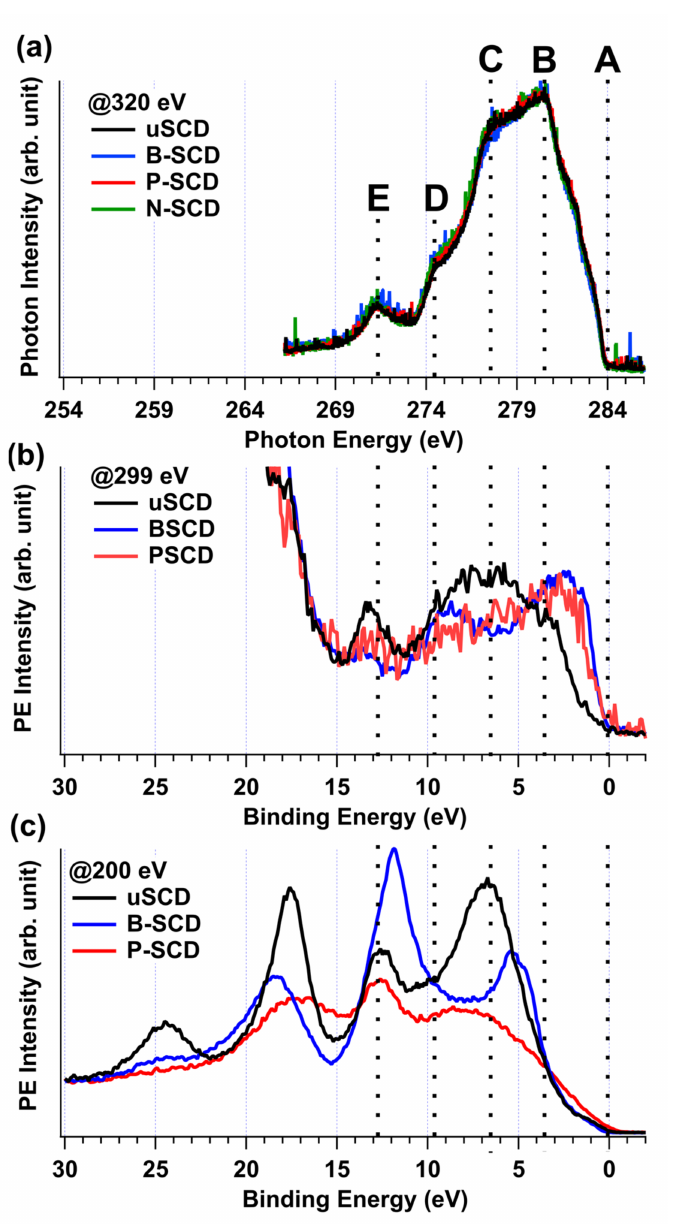
Figure 3. ( a ) XES at the C K-edge of uSCD, B-SCD, P-SCD and N-SCD recorded at 320 eV excitation energy. X-ray photoemission spectroscopy (XPS) of uSCD, B-SCD and P-SCD measured with 299 eV ( b ) and 200 eV ( c ) excitation energies. XES were normalized to the peak at 280.5 eV and XPS to the signal at 18 eV ( b ) and 30 eV ( c ). XES and XPS valence band spectra were plotted on a similar energy scale, aligning the valence band maximum from XES to the Fermi edge obtained from XPS, to facilitate comparison between the different